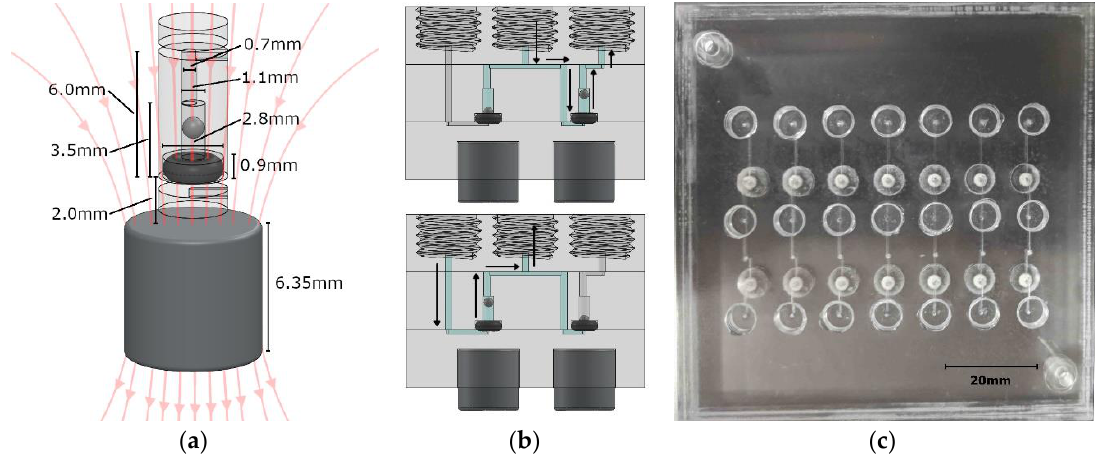
Figure 1. ( a ) CAD view of a single check valve, where the magnet position is adjusted/set to control the cracking pressure. ( b ) A valve system that is based on two check valves. The top image shows fluid dispensing, while the bottom image shows fluid withdrawal. A syringe screws into the center thread, while fluid lines connect to the inlet on the left and outlet on the right. ( c ) Photograph of a panel of valve systems used for testing and characterization.